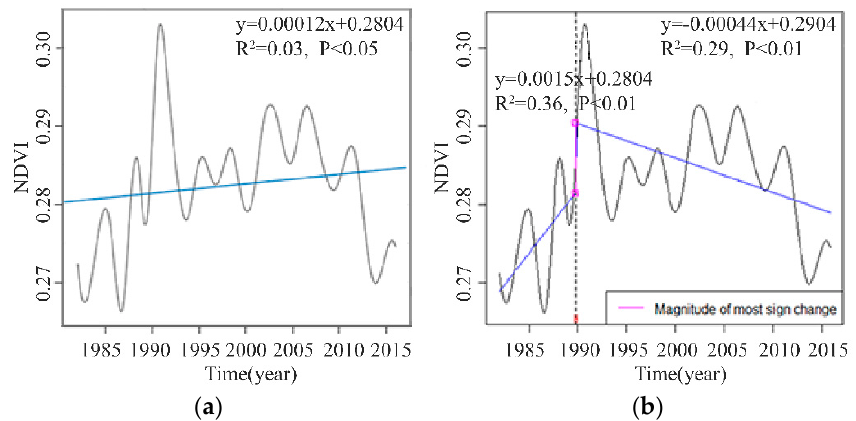
Figure 2. Interannual components of normalized difference vegetation index (NDVI) extracted from a spatial average time series at the whole HEM scale. for the period of 1982~2015 ( a ), and before and after the breakpoint time of 1989 ( b ).